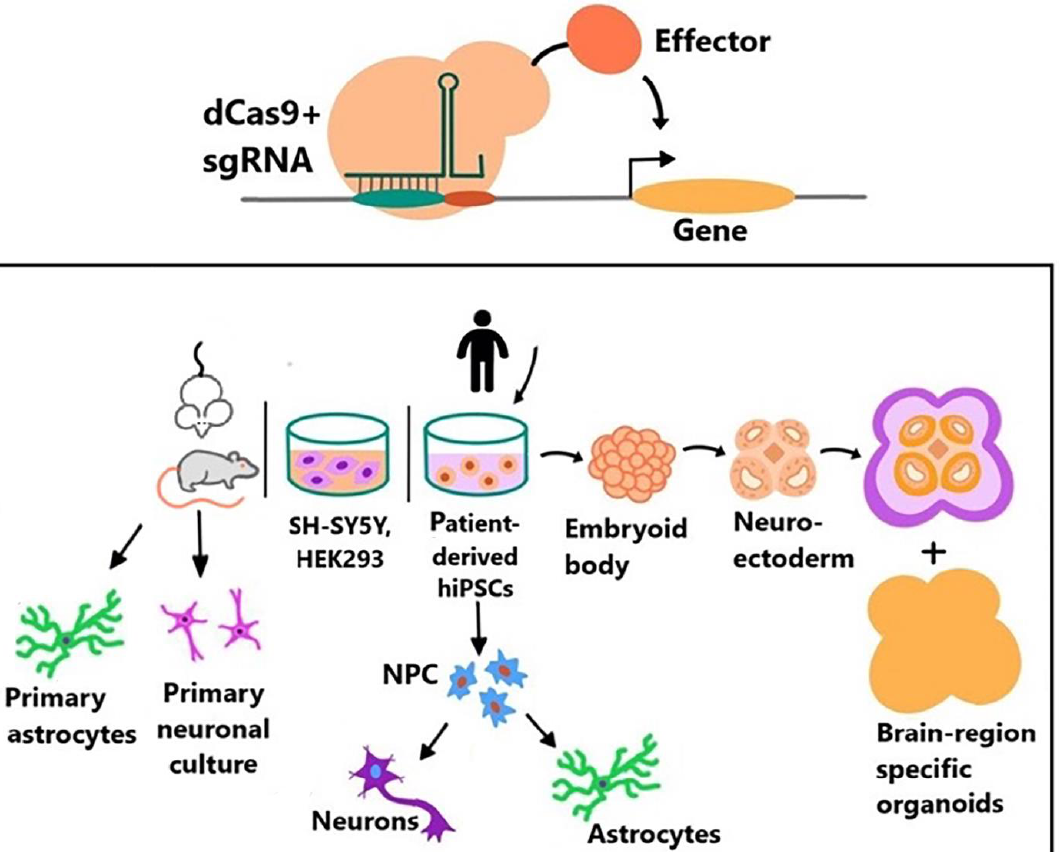
Figure 1. Models were used to study epigenetics of neurodevelopmental disorders.